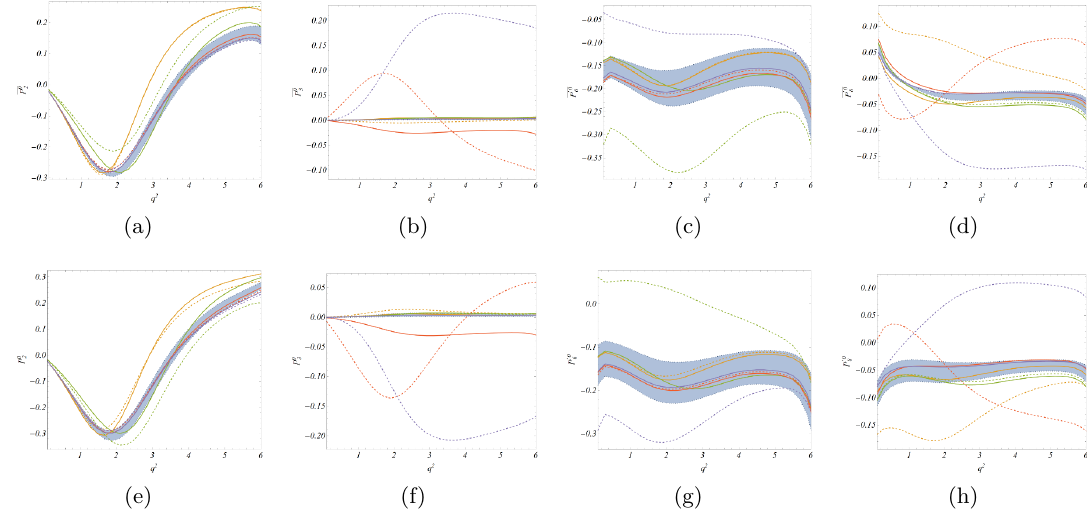
( ¯ P 0 ) , P 0 ( ¯ P 0 ) , P 0 0 ( ¯ P 0 0 ) , P 0 0 ( ¯ P 0 0 ) associated with ¯ B ( B ) → 2 2 3 3 6 6 8 8